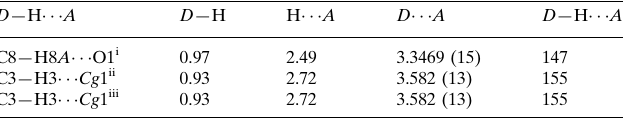
Hydrogen-bond geometry (A˚ , (cid:2)